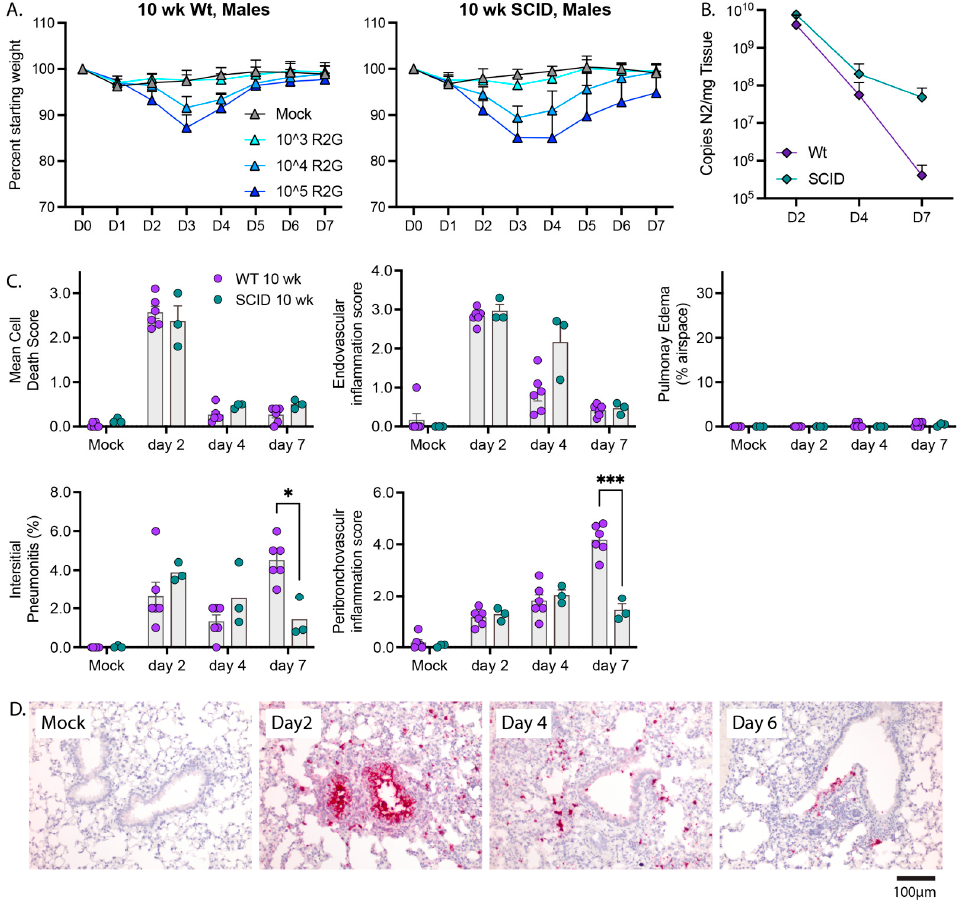
Figure 7. The adaptive immunity is not required for recovery from weight loss but is required for late time point control of virus. ( A ) Comparison of the dose response in regard to weight loss and recovery between 10 wk-old wt and SCID males with 5 mice per cohort. Note, data for wt males are repeated from Figure 3A. ( B ) Comparison of viral copy number between 10 wk-old wt animals and SCID males as determined by qPCR for copies of N2 per mg tissue. Note, data for wt animals are repeated from Figure 5 with 3 mice per cohort ( C ) Comparison of lung pathology between wt and SCID animals presented in B. Significance tested by 2-way ANOVA with Tukey’s adjustment for multiple comparisons, where * is p ≤ 0.05, and *** is p ≤ 0.001. ( D ) RNA-ISH for Spike sense strand. H&E stained FFPE tissue sections, and representative images can be found in Supplementary Figure